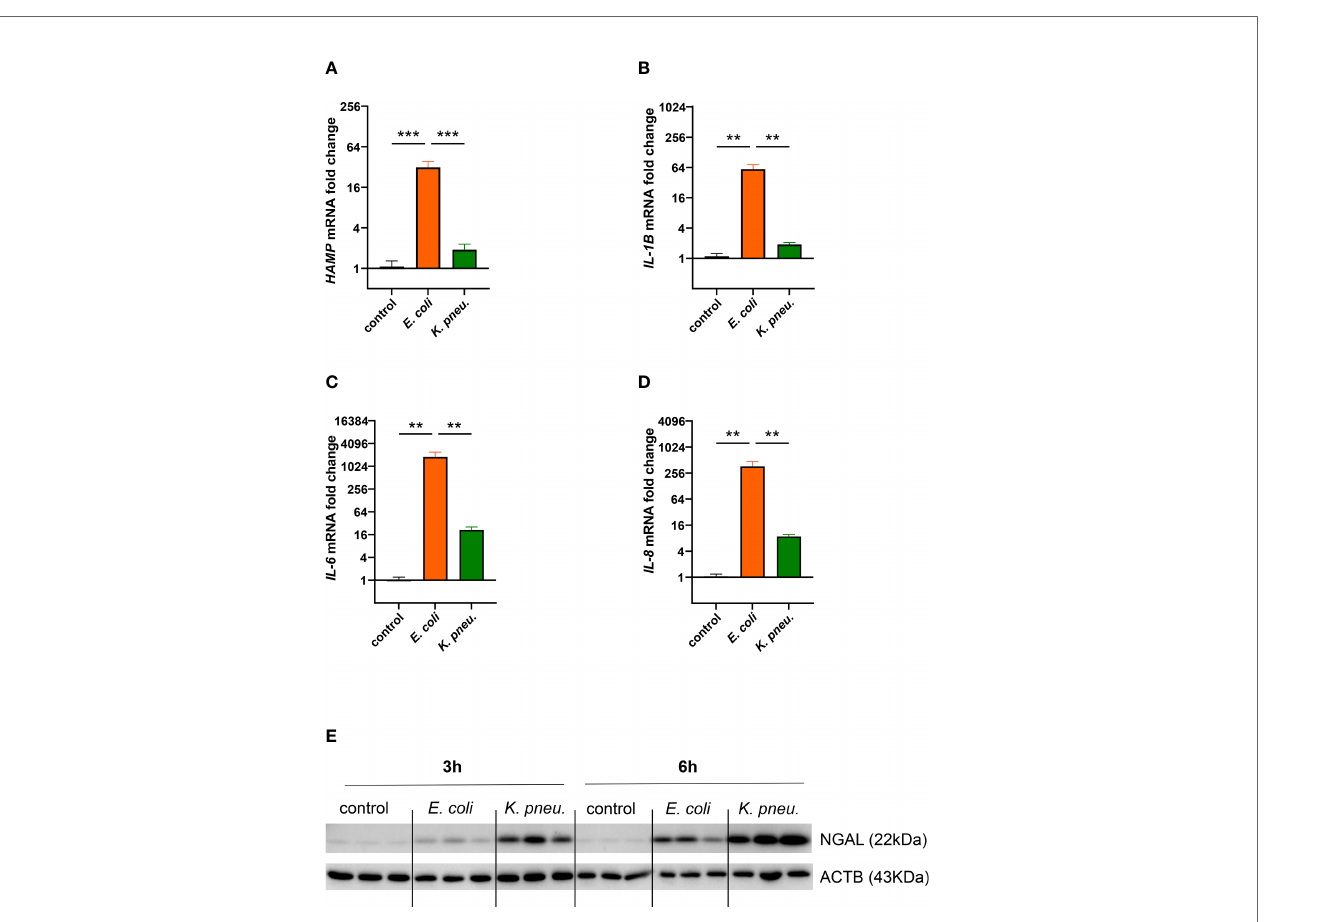
FIGURE 3 | Differential mRNA expression of HAMP (A) and pro-in fl ammatory cytokines IL-1B (B) IL-6 (C) , and IL-8 (D) in infected A549 cells.A549 cells were infected for 2h with E. coli or K. pneumoniae at MOI of 10, subsequently washed thoroughly and harvested after 3h (A) or 6h (B – D) of intracellular infection. Data from three separate experiments are shown as mean ± SEM.Western blotting of NGAL in infected AECII (E) . A549 cells were infected for 2h with E. coli or K. pneumoniae at MOI of 10, subsequently washed thoroughly and harvested after 3h (left) or 6h (right) of intracellular infection. Representative image of three separate experiments. ** denotes p<0.01, *** denotes p<0.001 for post-hoc statistical testing. K. pneu., K. pneumoniae ; HAMP, hepcidin antimicrobial peptide; NGAL, neutrophil gelatinase-associated lipocalin 2; ACTB, b